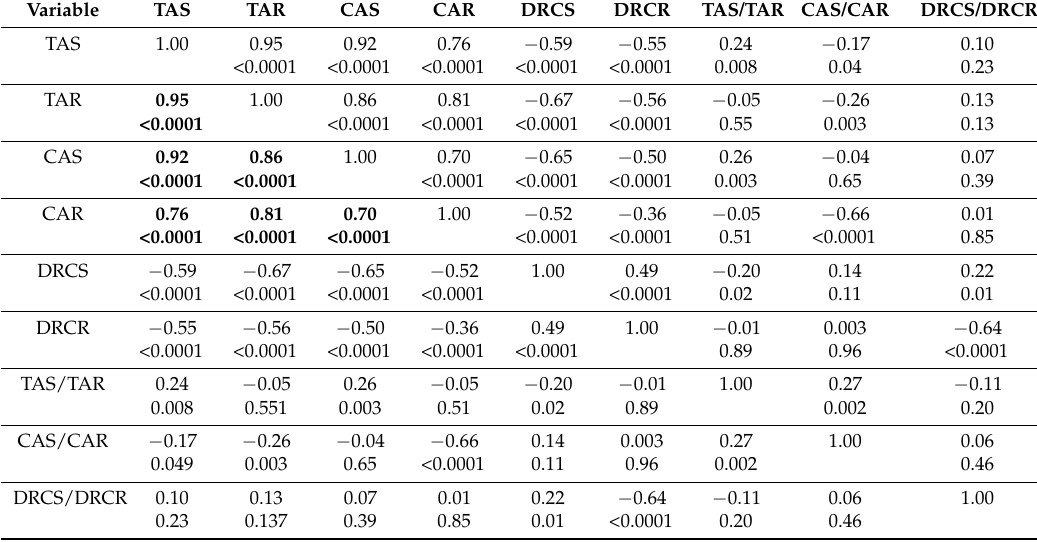
Table 8. Correlation matrix of anatomical variables of scions and rootstocks, considering all of the performed grafts.